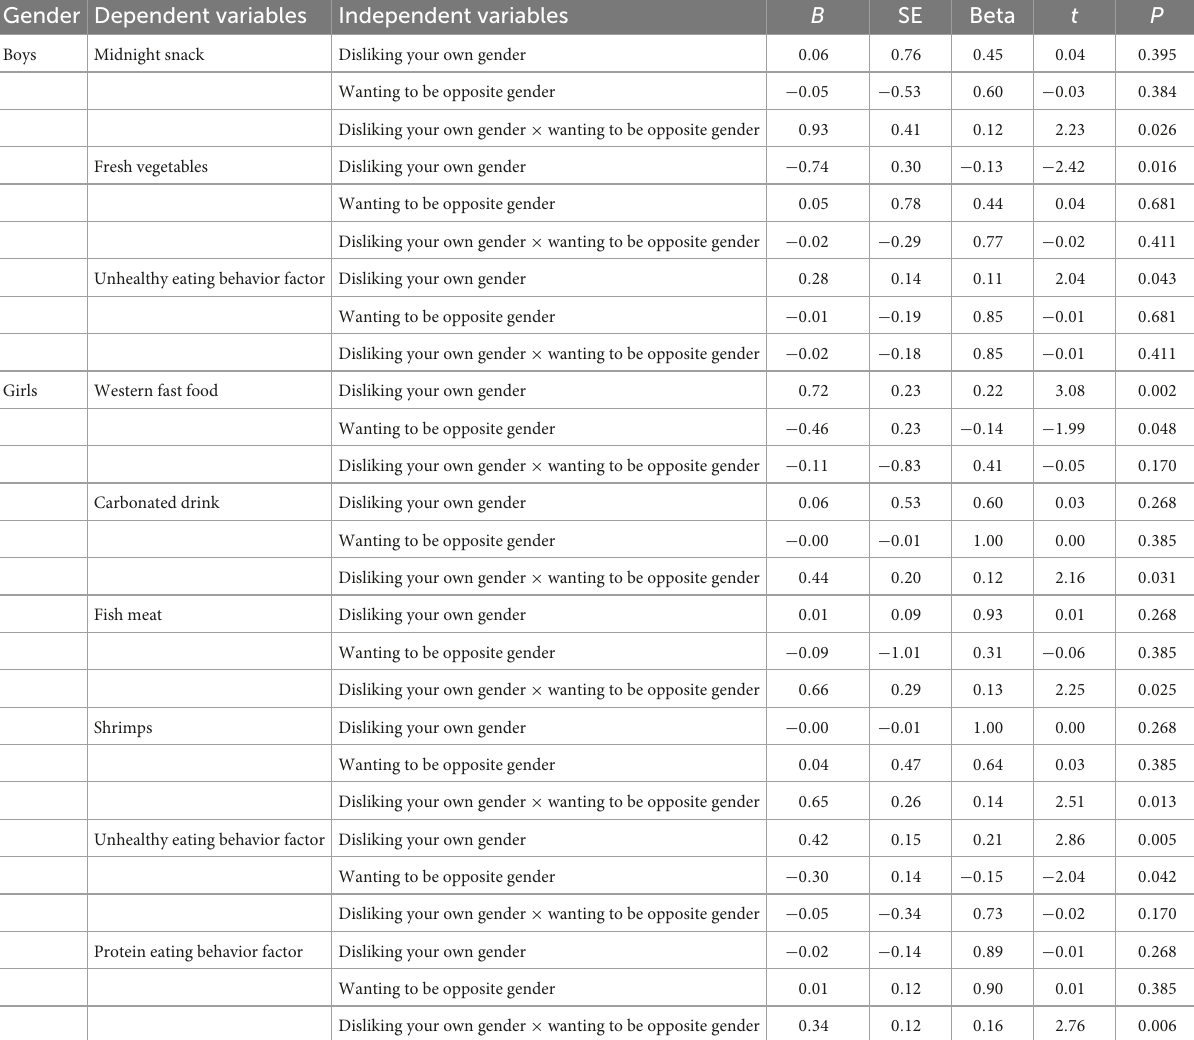
TABLE 6 The results of multiple linear regression on associations between eating behaviors and negative gender attitude after adjusting for age, overall obesity and abdominal obesity. Gender Dependent